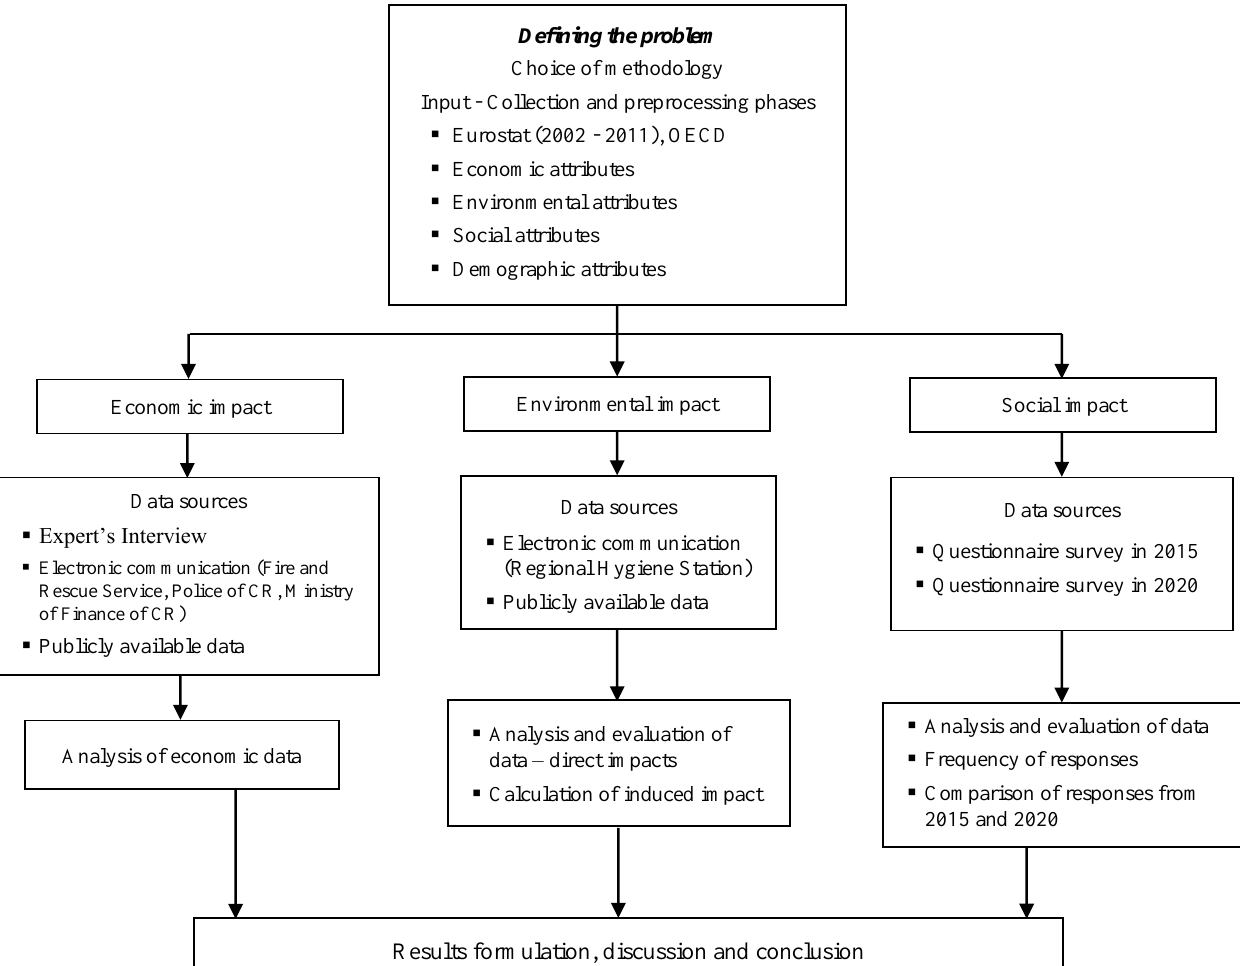
Figure 1. The research